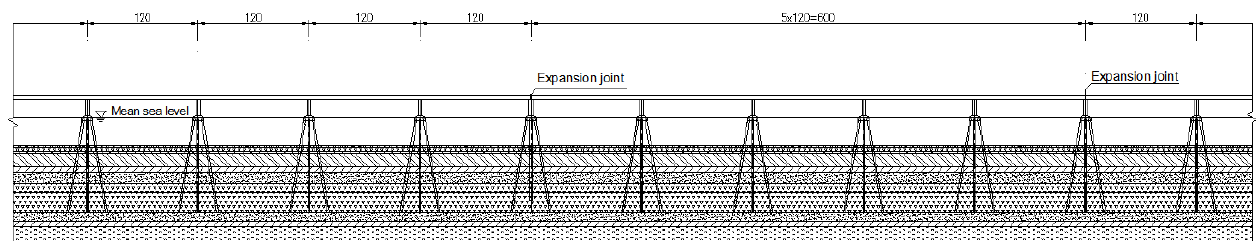
Figure 3. Overall layout diagram of the bridge in this study (unit: m).